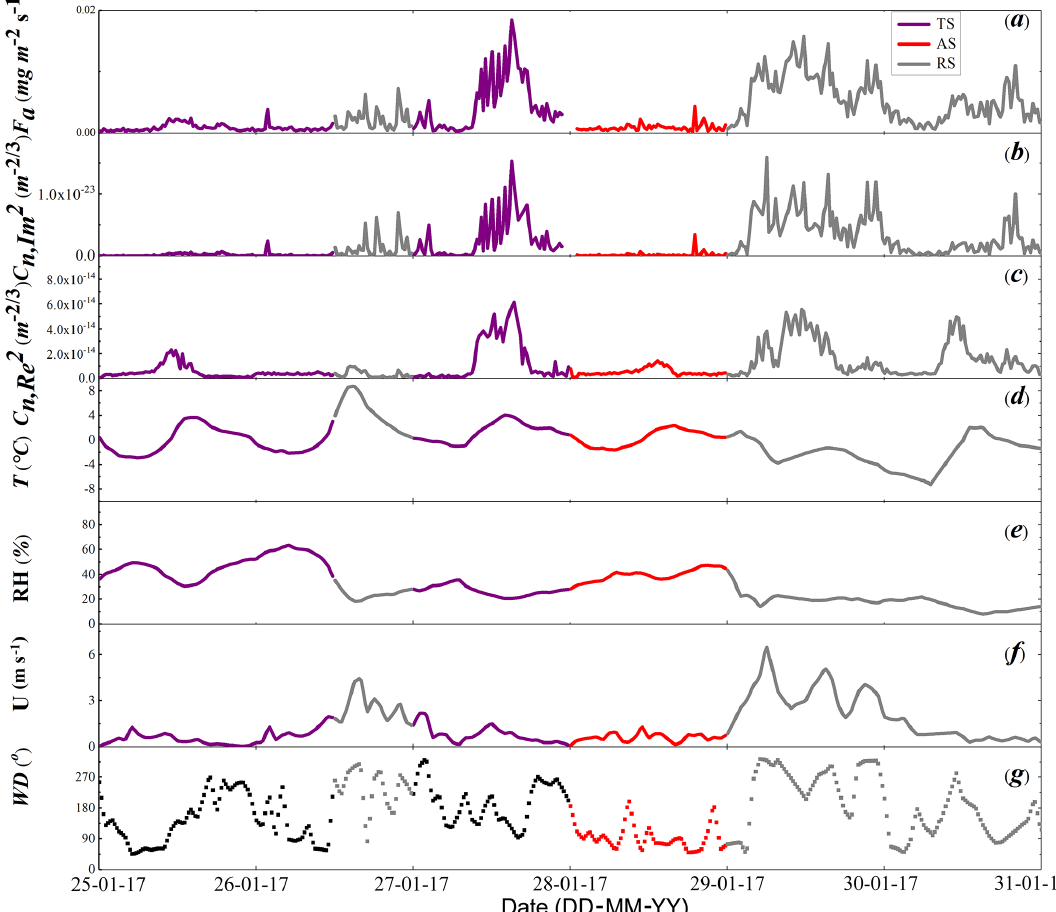
Figure 6. Temporal variations in (a) aerosol flux, (b) imaginary part of the AERISP, (c) real part of the AERISP (d) air temperature, (e) RH, (f) wind speed, and (g) wind direction in the Beijing area during a heavy pollution period, i.e. 25 to 31 January